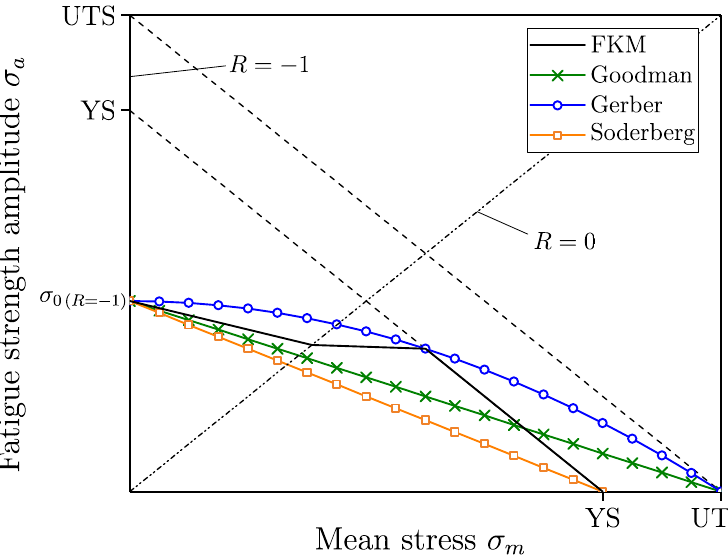
Figure 2. A Haigh diagram exhibiting commonly utilized mean stress models. FKM (“Forschungskuratorium